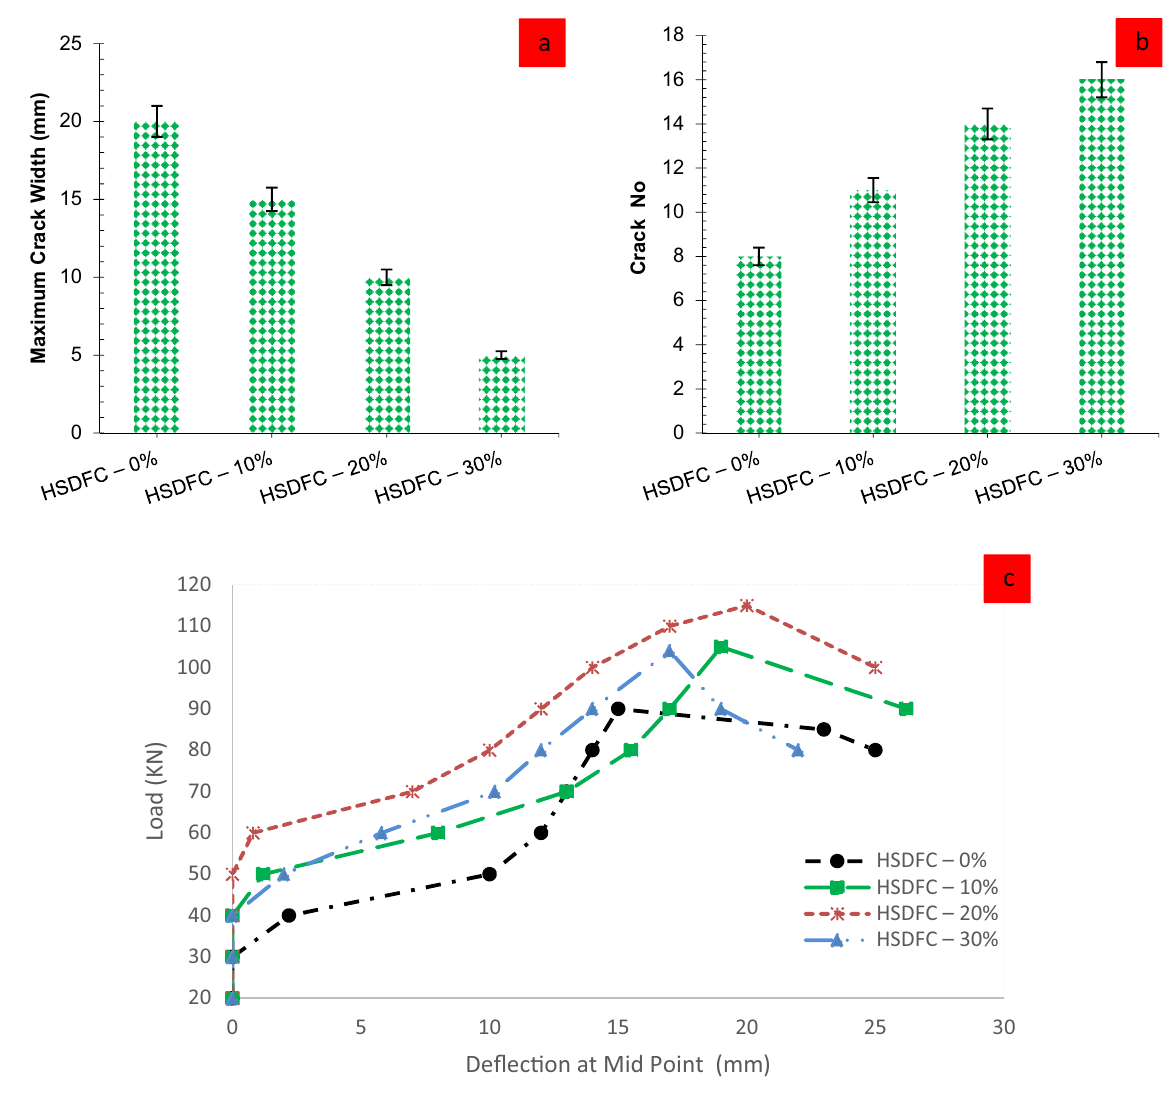
Figure 10. ( a ) Max crack width, ( b ) Crack number and ( c ) Load deflection.